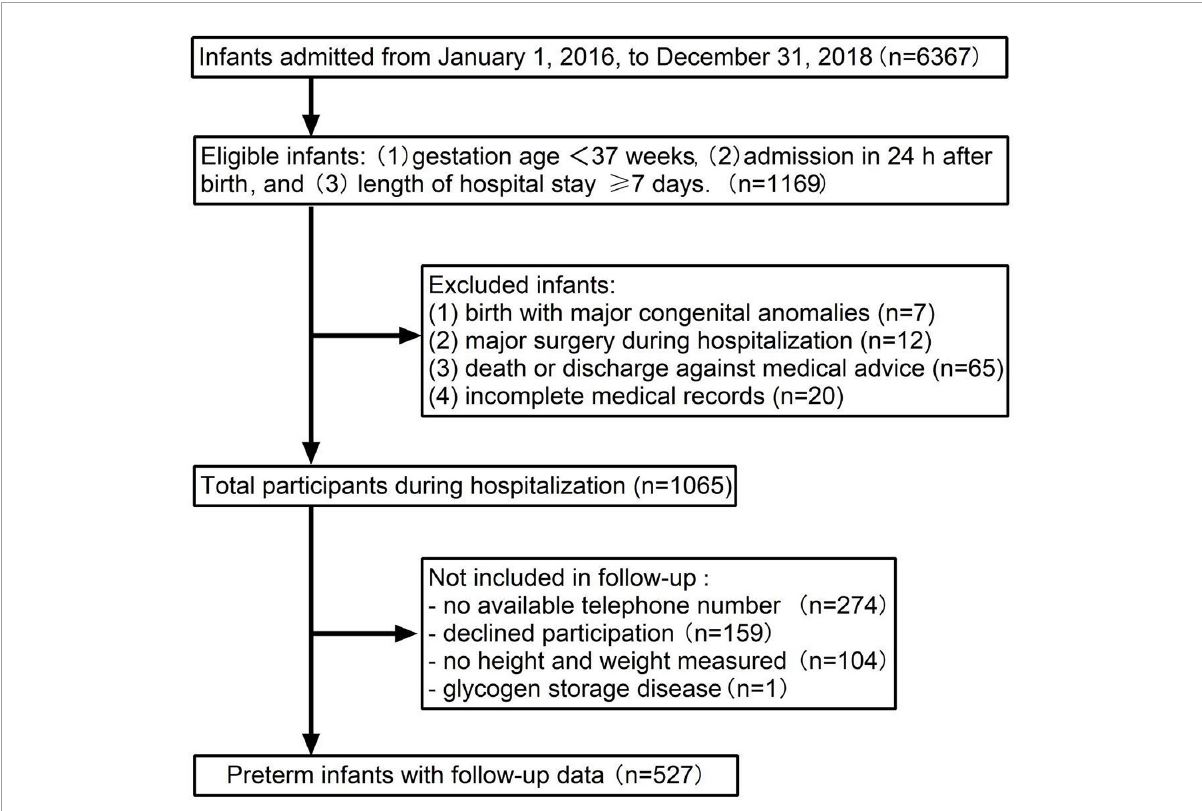
FIGURE1 Flowchart of